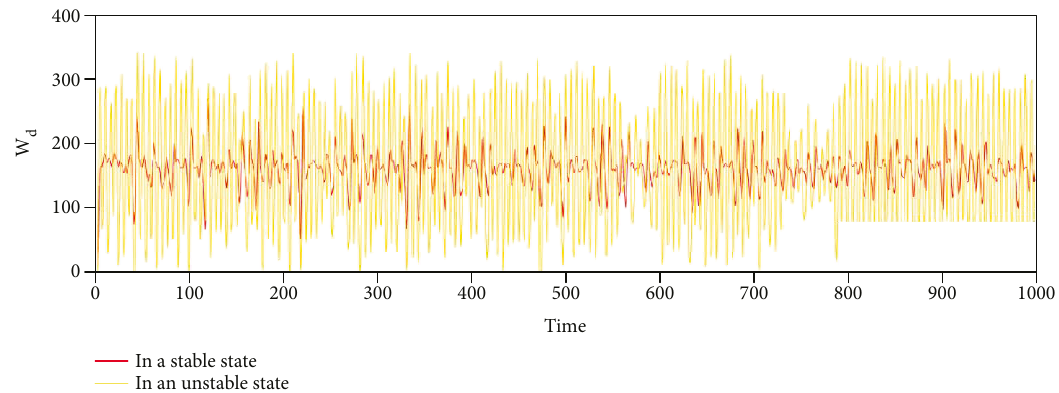
Figure 21: Comparison of tra ffi c volume changes of third-party logistics service providers in a stable state and unstable state under the scenario of random demand obeying normal